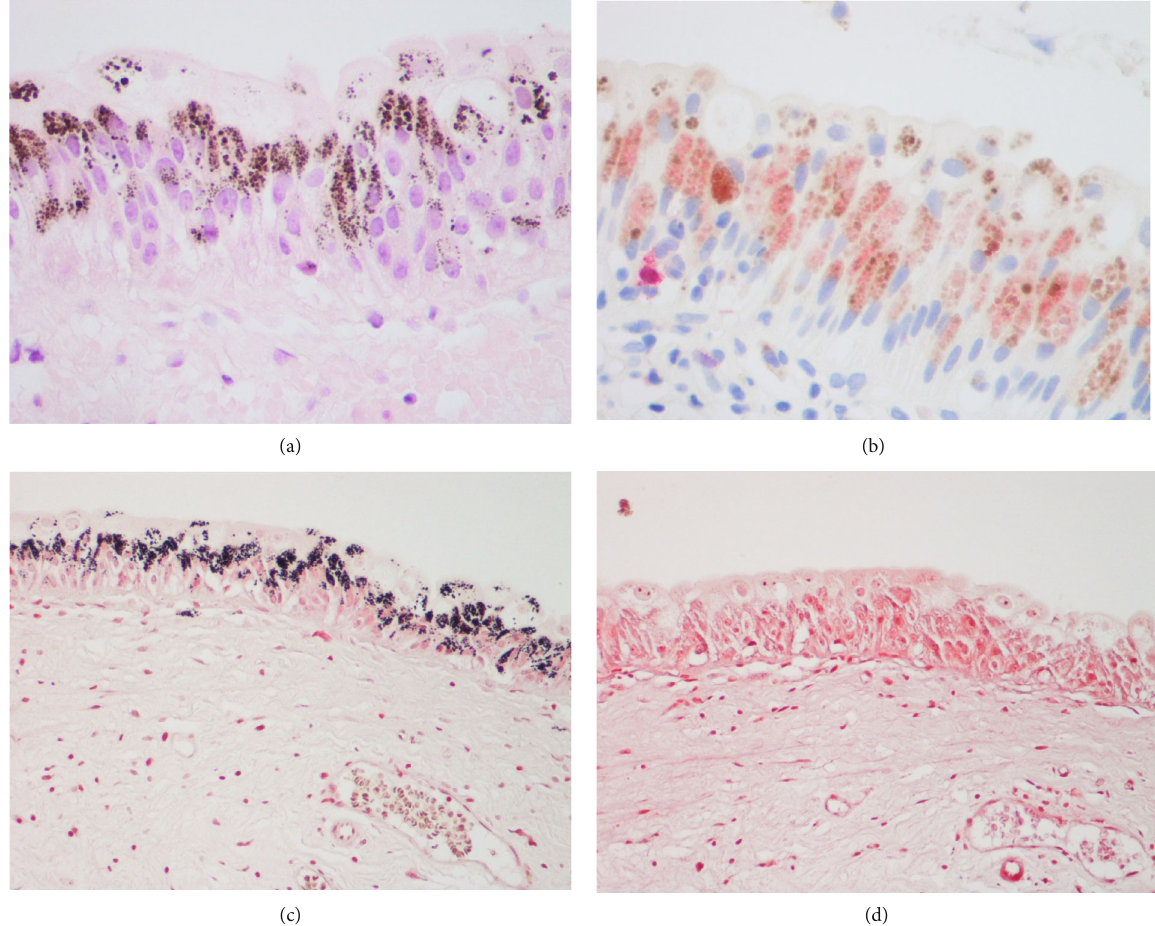
Figure 2: Histopathological preparations of bladder mucosa showing melanosis. (a) H&E-stained section showing melanin in the urothelium. (b) Many of the pigmented urothelial cells are immunoreactive for S100 protein (red stain). (c) The melanin is shown (black) in a Masson Fontana preparation. (d) The Masson Fontana reaction is abolished by prior treatment of the section with a